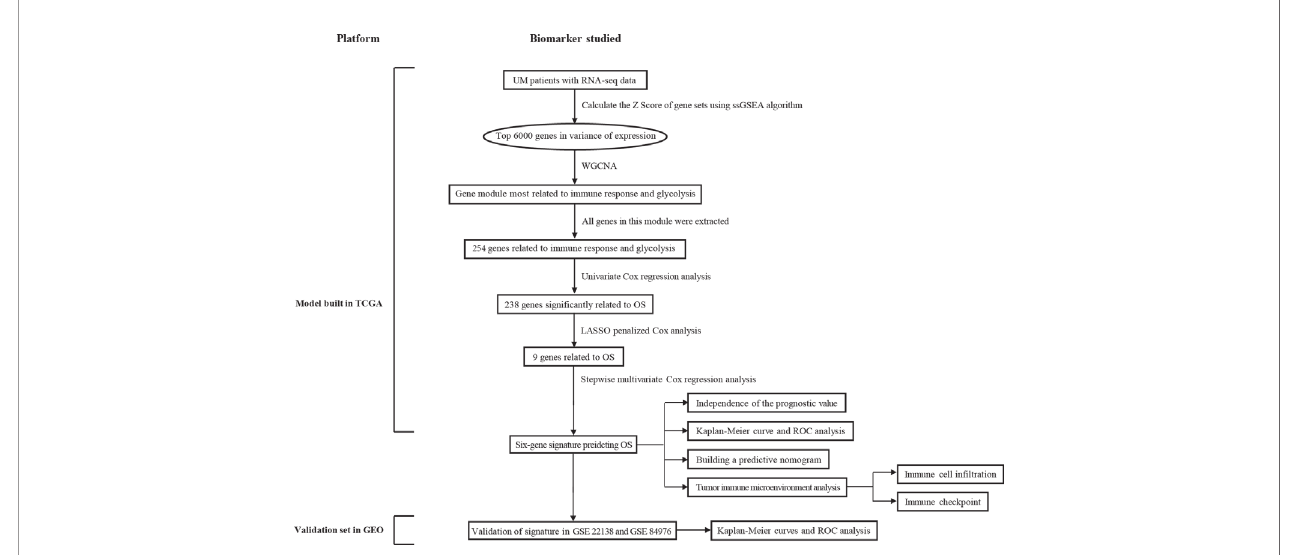
FIGURE 1 | Overall fl owchart of this study. LASSO , least absolute shrinkage and selection operator; UM , uveal melanoma; ssGSEA , single-sample gene set enrichment analysis; ROC , receiver operating characteristic; WGCNA , weighted gene co-expression network